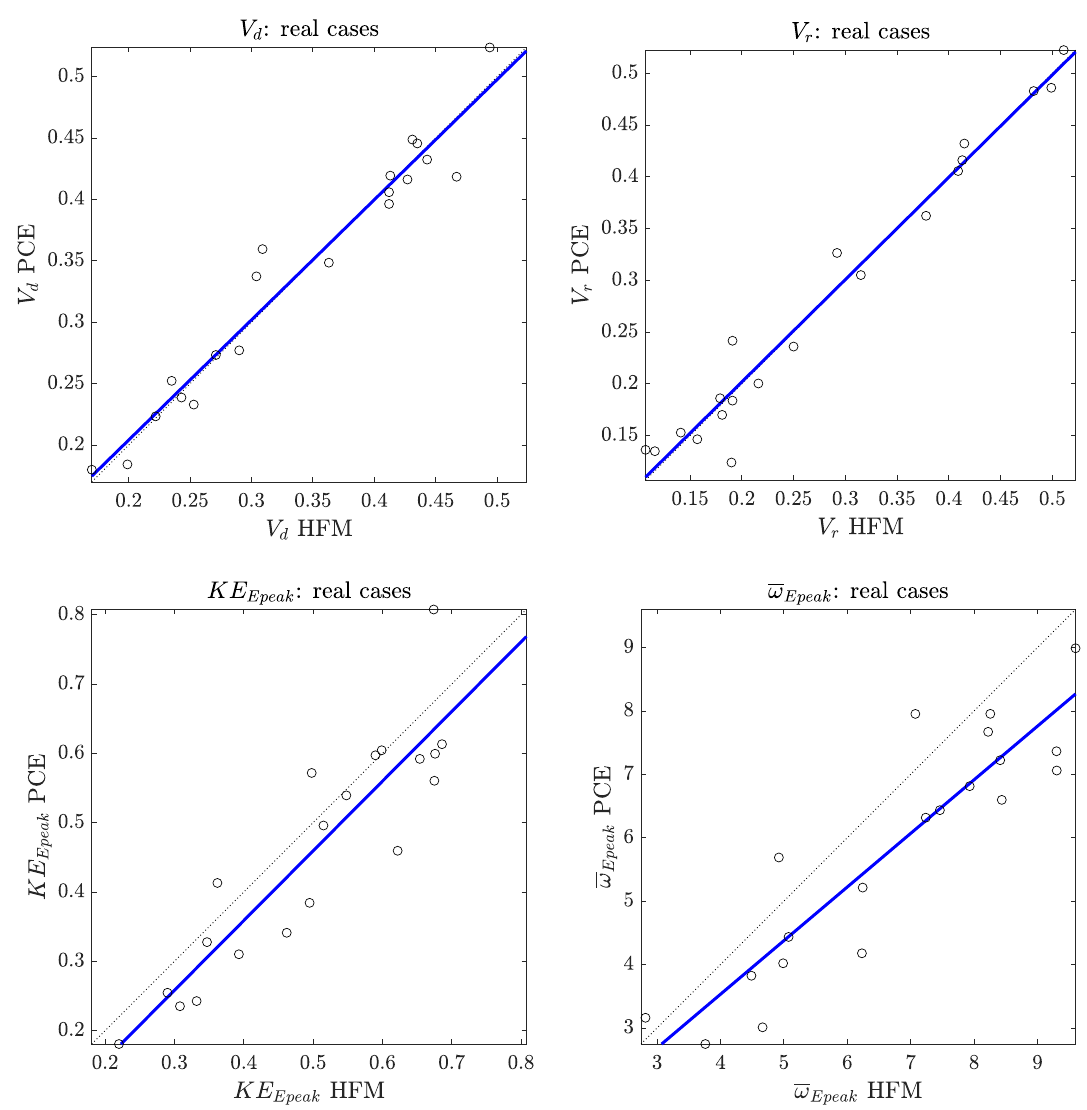
Figure 3. Comparison between HFM and PCE predictions against real cases. Solid blue lines represent the linear regressions, while dashed lines are the bisectors. Characteristics of regression lines: V d PCE = 0.98 · V d HFM + 0.0084 ( R 2 = 0.95, p − value = 2.41 E − 13 ) ; V r PCE = 0.99 · V r HFM + 0.0041 ( R 2 = 0.97, p − value = 6.41 E − 15 ) ; KE Epeak PCE = 1.00 · KE Epeak HFM − 0.043 ( R 2 = 0.82, p − value = 4.98 E − 08 ) ; ω Epeak PCE = 0.85 · ω Epeak HFM + 0.15 ( R 2 = 0.82, p − value = 4.23 E − 08 )